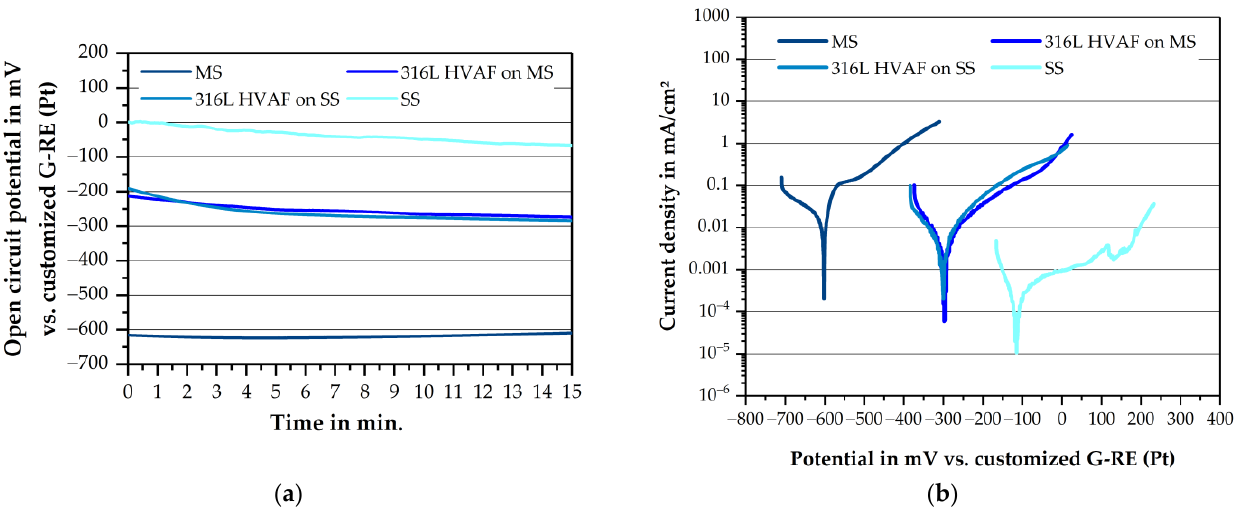
Figure 7. Representative curves of the electrochemical measurements in the 3.5% NaCl gel electrolyte for the AISI 316L HVAF coatings on mild steel (MS) and stainless steel (SS) and reference bulk materials, mild steel (MS) and stainless steel (SS): ( a ) OCP and ( b ) polarization